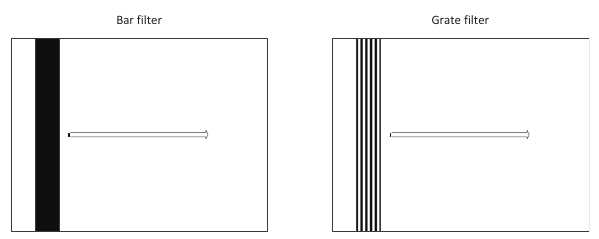
Fig. 5 Horizontal axis’ brightness values and identified result (with grate